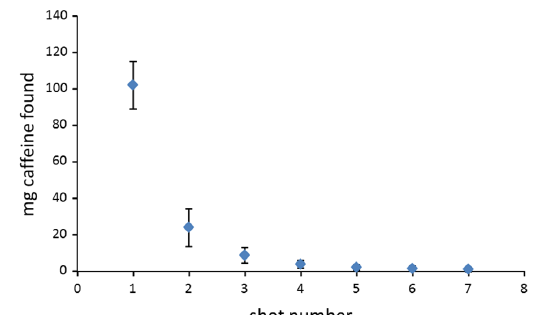
Figure 4. Evolution of the mg of caffeine detected in seven consecutive espresso shots collected using the same charge of ground coffee ( n = 4, verticals bars show the calculated standard deviation).